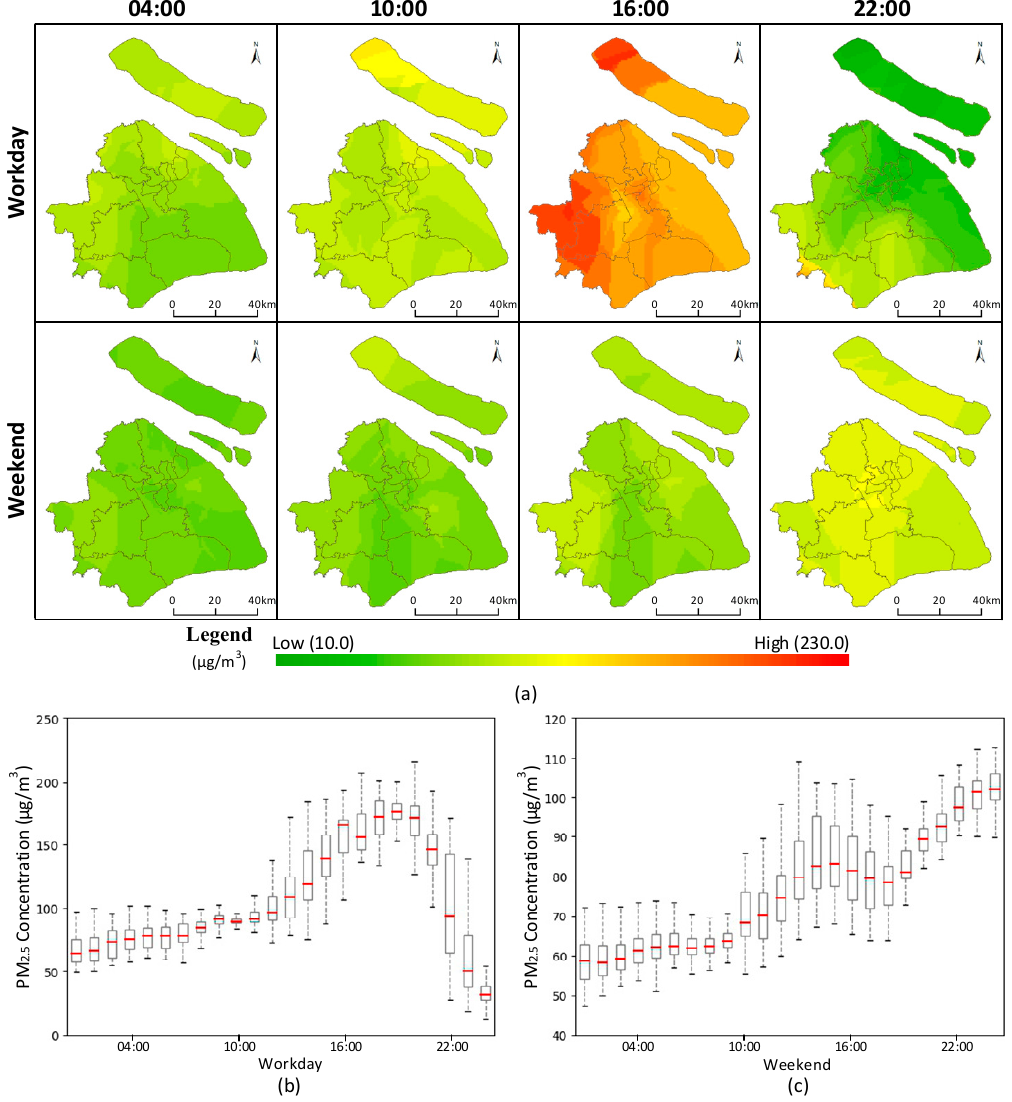
Figure 8. Di ff erent facets of PM 2.5 concentration. ( a ) Hourly maps of PM 2.5 concentration distribution on a workday and a weekend. ( b ) Temporal variation of PM 2.5 concentration on a workday. ( c ) Temporal variation of PM 2.5 concentration on a